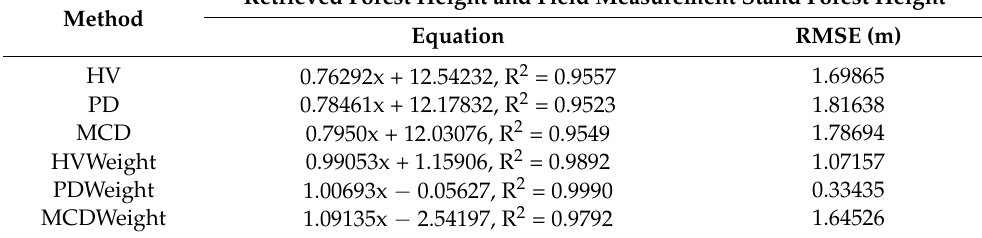
Table 5. The fitting equation between the retrieved forest height and the field measurement stand forest height. Retrieved Forest Height and Field Measurement Stand Forest Method